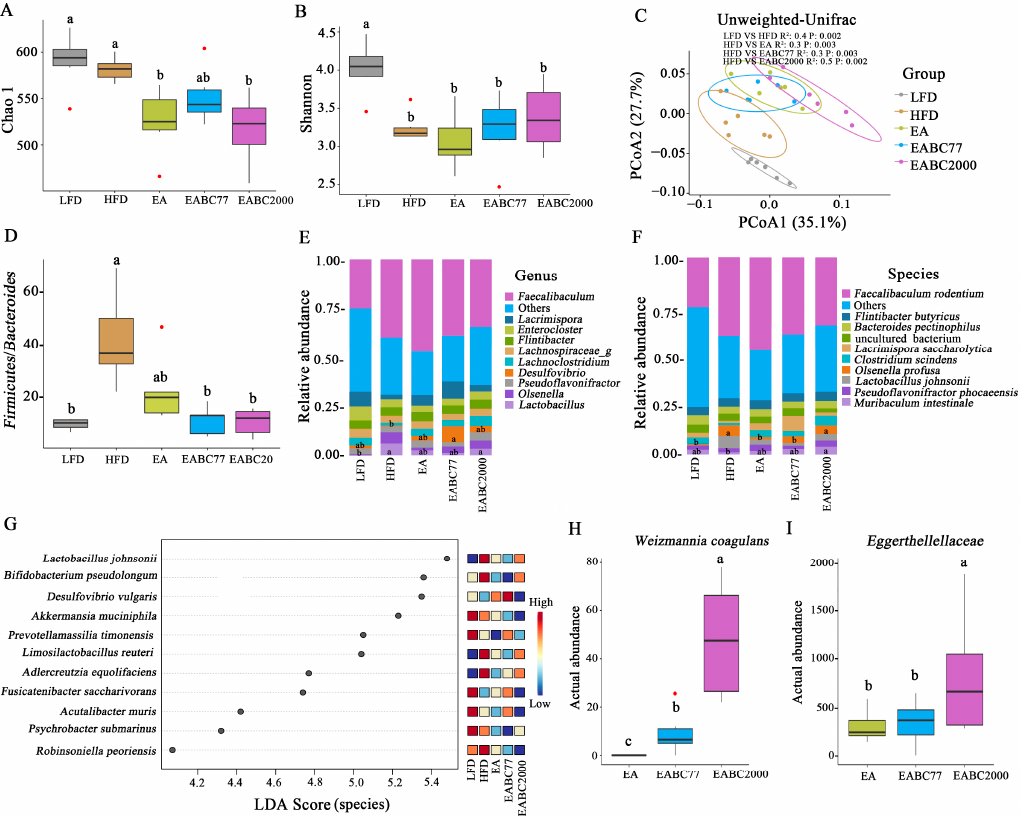
Figure 2. Effect of jointly consuming Weizmannia coagulans BC2000 and ellagic acid on cecum microbiota of mice. ( A ) Chao1 index; ( B ) Shannon index; ( C ) Principal coordinate analysis (PCoA) score plots; ( D ) Firmicutes/Bacteroides ratio; ( E ) relative abundance of the genus; ( F ) relative